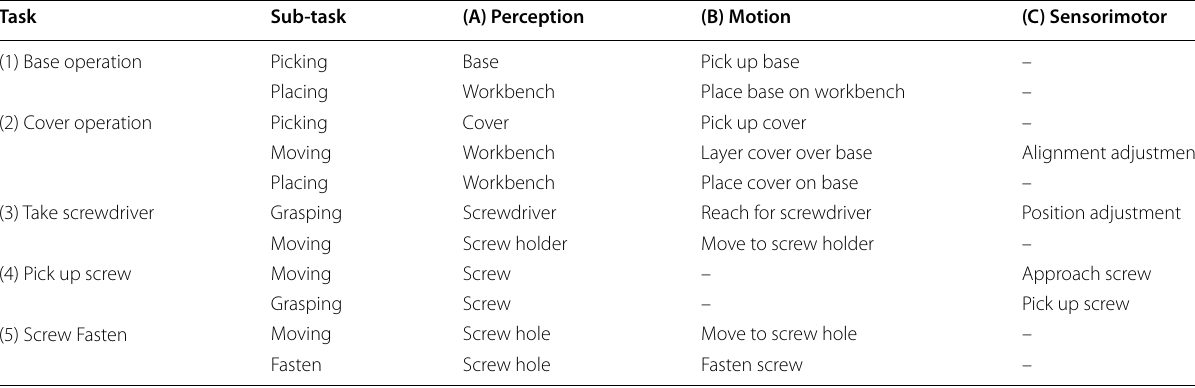
Table 2 Task categorization for assembly work